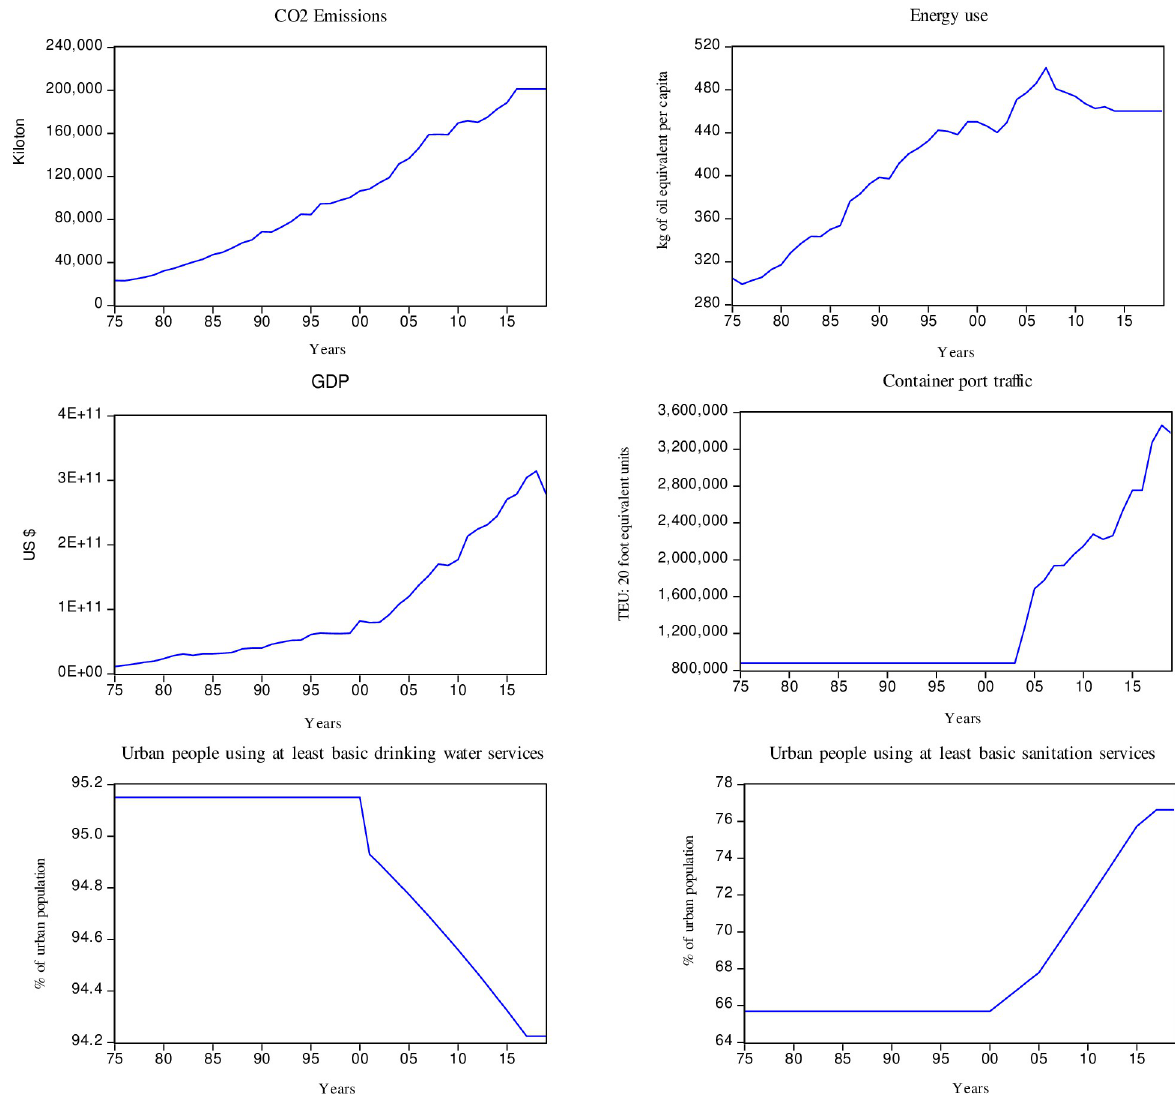
Fig 1. Trend analysis of the studied variables. Source: World Bank